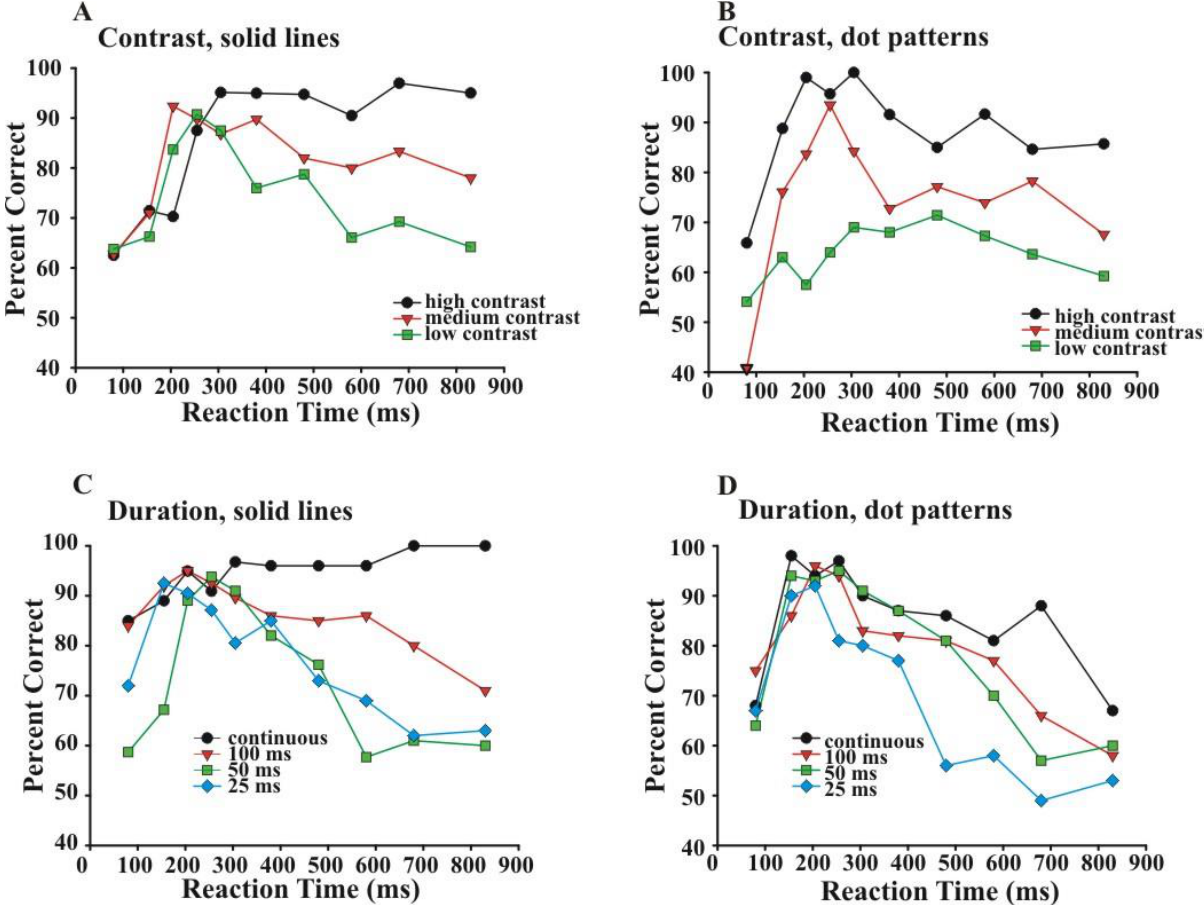
Figure 4 . Example of performance by an individual rat for each stimulus condition: A . contrast with solid lines, B . contrast with grouped dots, C . duration with solid lines, and D . duration with grouped